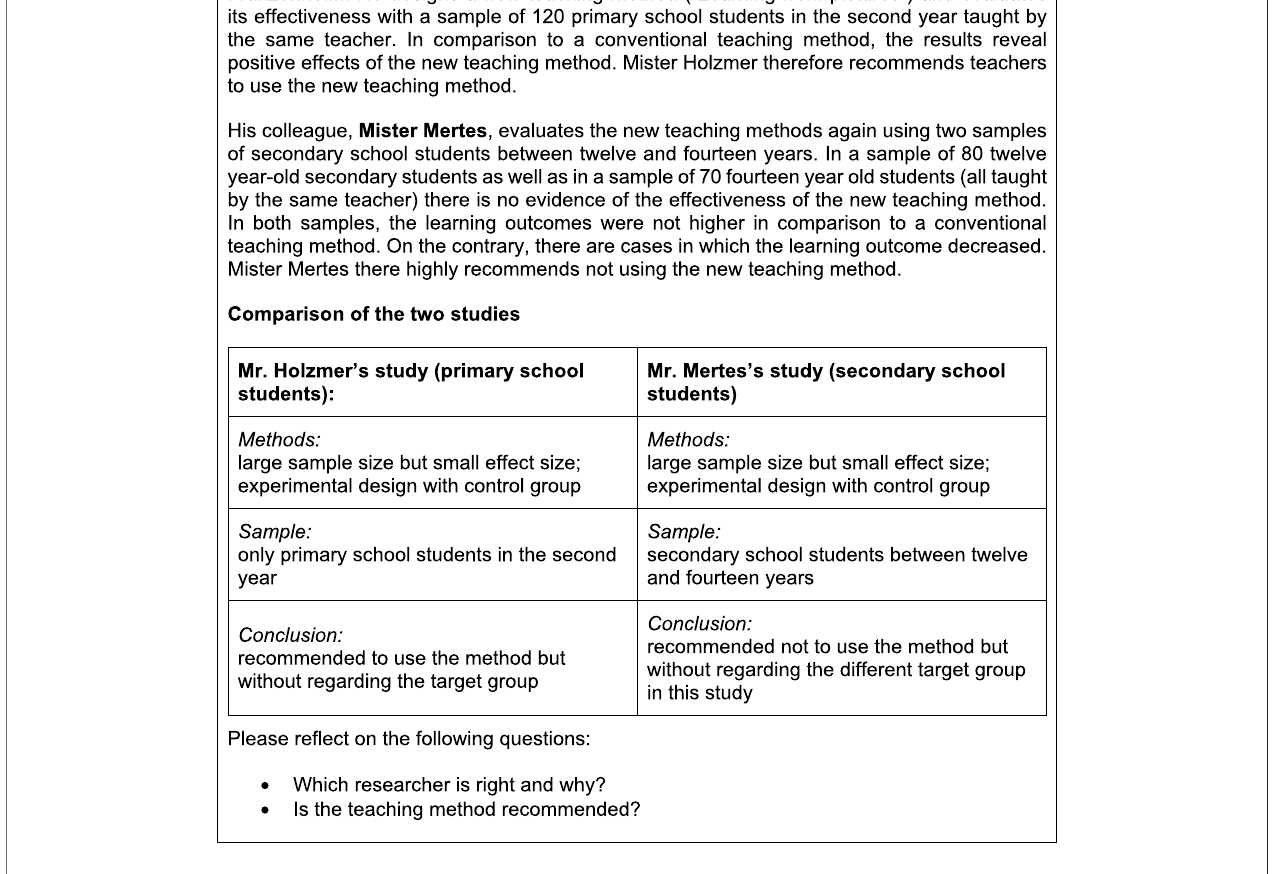
FIGURE 3 | First fi ctitious example from the